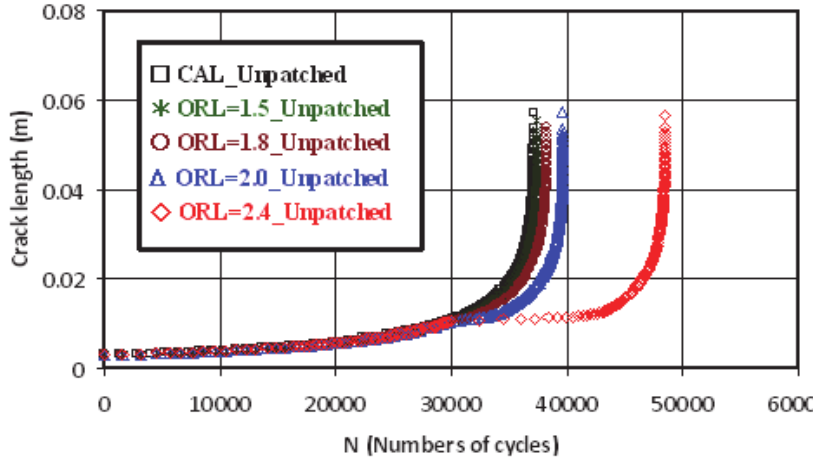
Figure 3: Overload ratio effect on fatigue life for unpatched 2024 T351